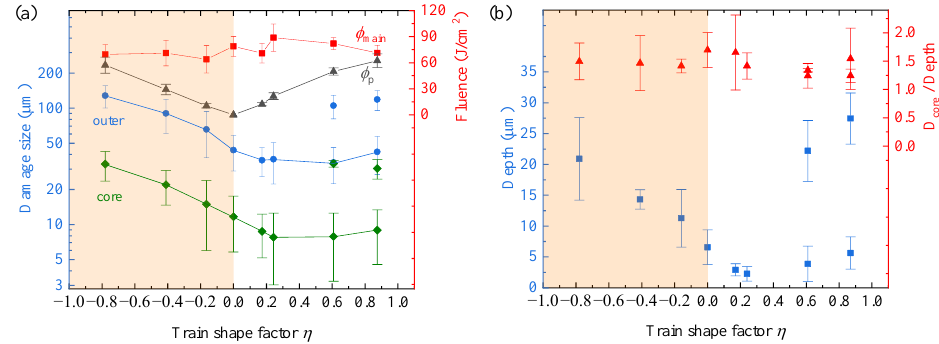
Figure 8. The statistical average size dependence of ( a ) the outer and ( b ) core regions of the damage sites on main-pulse fluence for η = 0 (single-pulse), η = 0.24 and η = 0.61 based the original data in the red dashed frames in Figure 6.